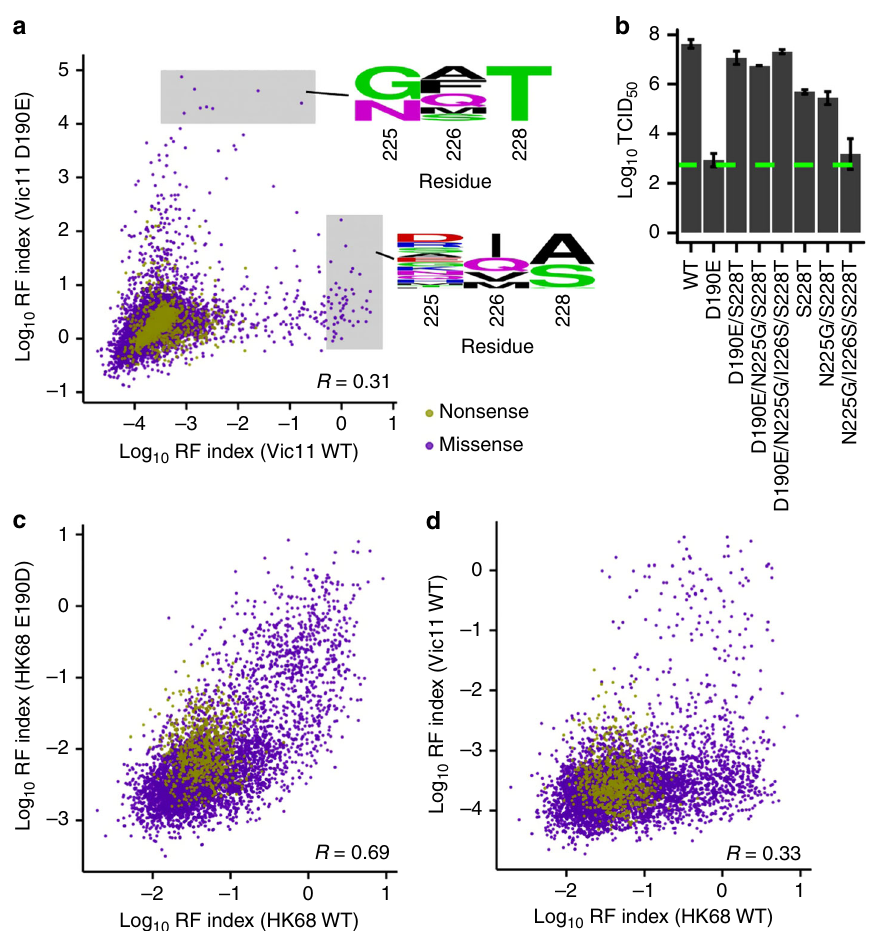
Fig. 6 Deep mutational scanning of residue 225, 226, and 228. a Log 10 RF index of each variant is compared between Vic11 WT and D190E genetic backgrounds. b Effect of different combinations of substitutions on Vic11 replication fi tness was examined by virus rescue experiments. Virus titer was measured by TCID 50. Error bars indicate the standard deviation of three independent experiments. The green dashed line represents the lower detection limit. c , d Log 10 RF index of each variant is compared between c HK68 WT and E190D genetic backgrounds and d Vic11 WT and HK68 WT